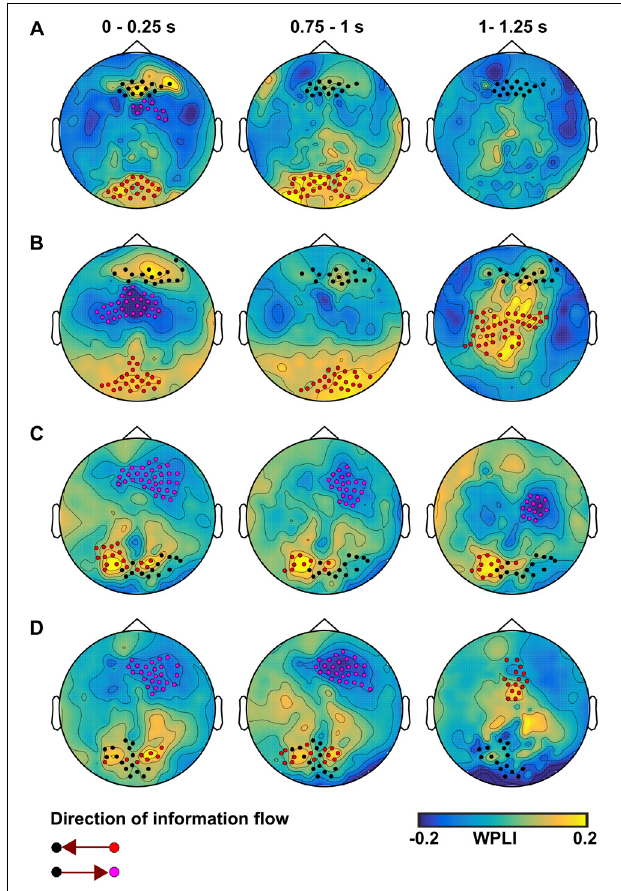
FIGURE 7 | The information flow at EEG electrode level during CS+ compared to CS– in the theta band for (A) the no-TMS experiment and (B) the TMS experiment. In the alpha band, the information flow is shown for (C) the no-TMS experiment and (D) the TMS experiment. The time windows are labeled above the plot, while the direction is indicated below. The highlighted electrodes were identified with cluster-based statistics ( p < 0.05).